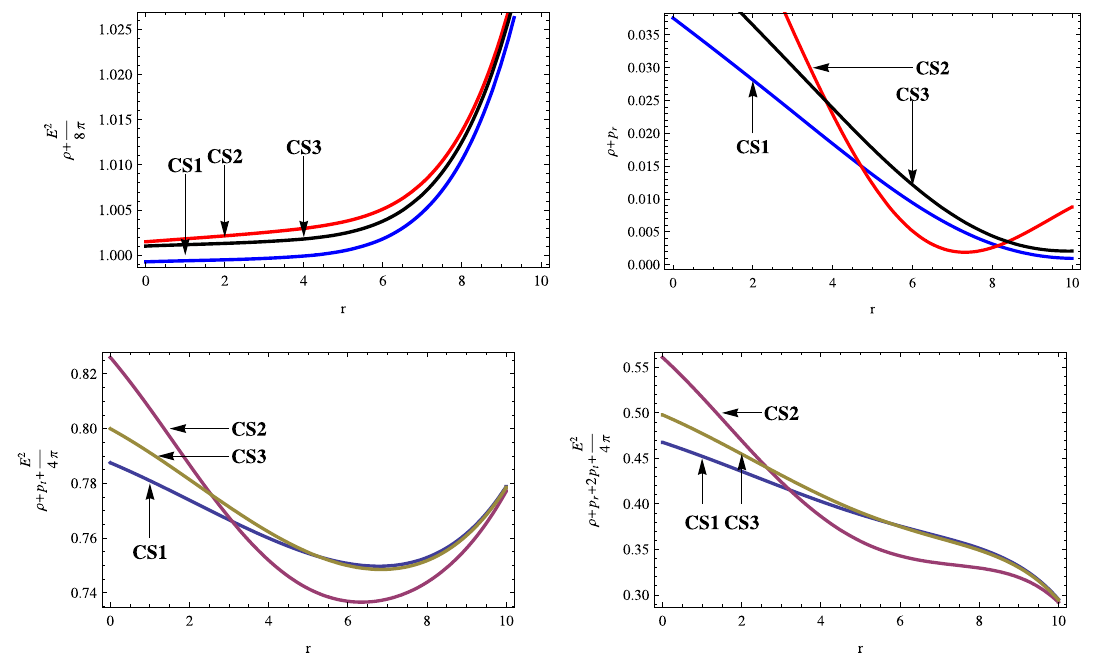
Fig. 10 Variations of energy conditions versus r (km) with the numerical values of A , B and C from Table 2 ≥ 0 NEC : ρ + E 2 8 π